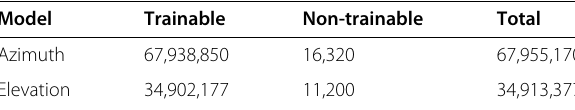
Table 1 Total number of parameters for DOANet models